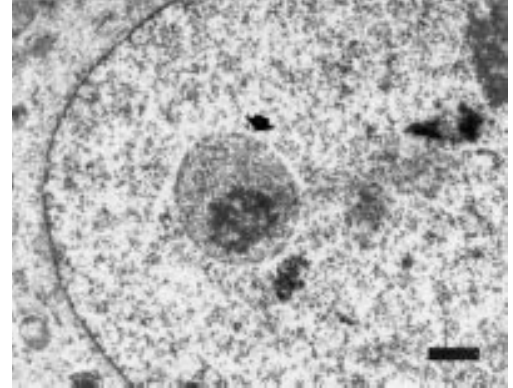
Fig. 8. Nuclear body (arrow) in the nucleoplasm of a macronucleus. Bar 0.5 (cid:22) m.